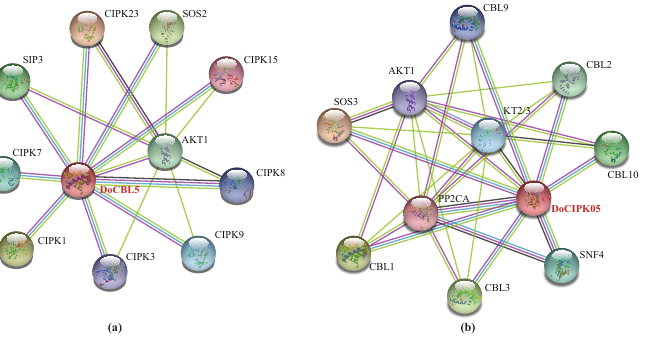
Figure 9. Protein–protein interaction network of DoCBL5 protein ( a ) and DoCIPK05 protein ( b